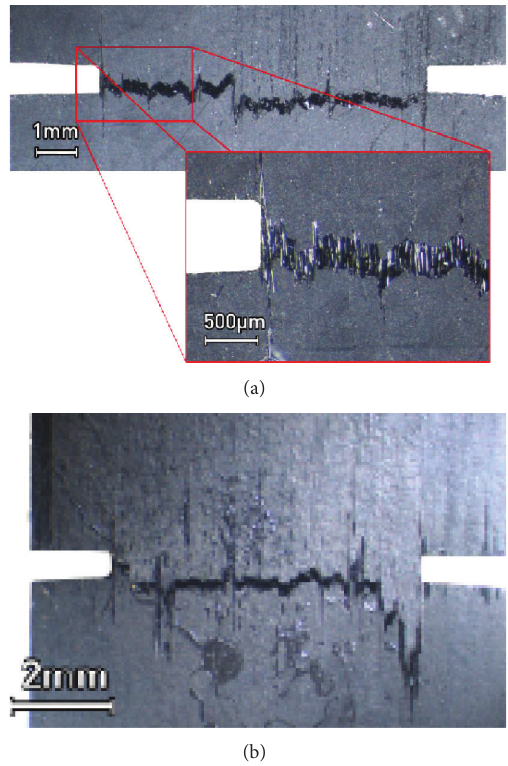
F 3: Postmortem optical stereoscope images of the notched lengths of a notched SiC/BMAS ceramic matrix composite demon- strating the dominant macrocrack and crack de�ection path and magni�cation showing large-scale bridging and pullout phenom-